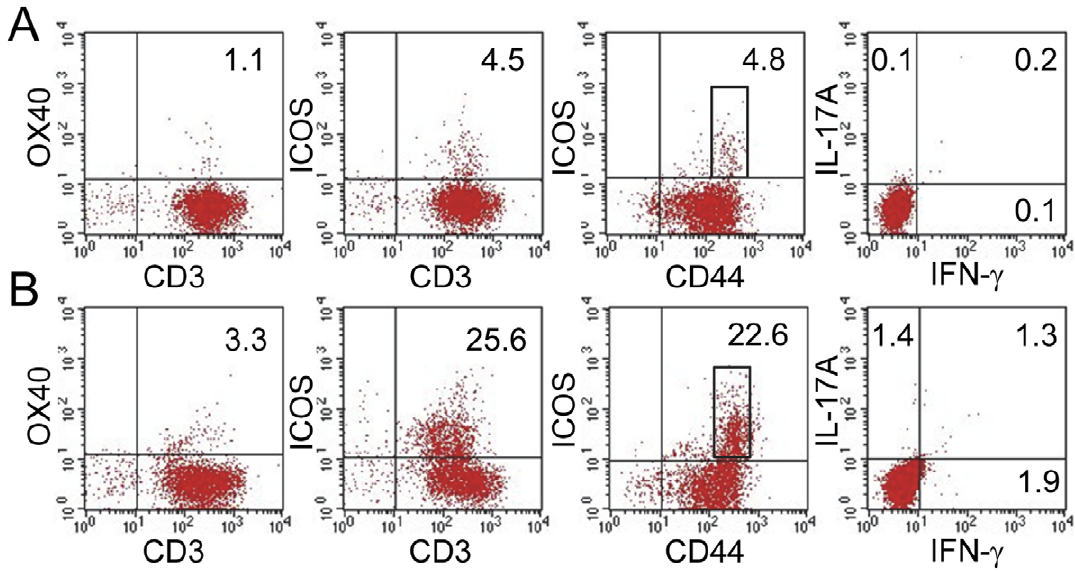
Figure 6. Characterization of siIELs in Roquin san/san mice. siIELs from Roquin san/san mice have more (panel B ) ICOS + T cells, including a subset of CD44 hi ICOS + cells compared to (panel A ) normal animals. Interestingly, neither IL-17A nor IFN- c were produced to any appreciable levels in either type of mouse (panels A and B). Representative data from 2 normal and 2 Roquin san/san mice.